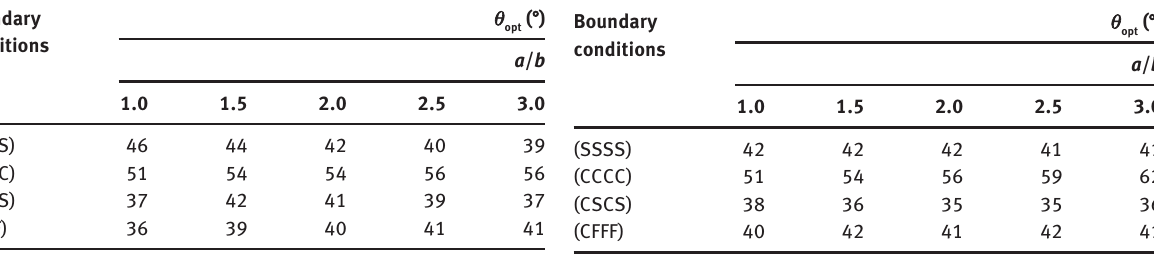
Table 2 Effects of a / b ratios and boundary conditions on